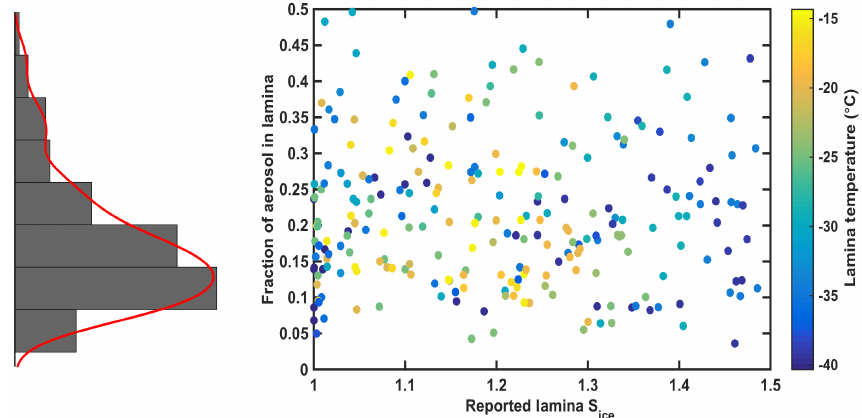
Figure 5. Measured f lam as a function of S ice in the aerosol lamina in SPIN. Temperature for each data point is noted by the color bar. The histogram on the left is the distribution of f lam from the measurements with the corresponding kernel density estimate shown in red.